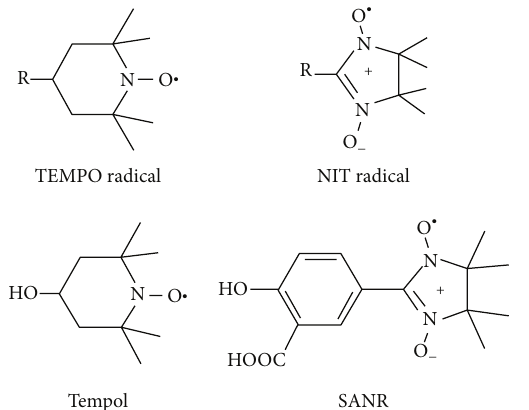
Figure 1: Structure of SANR and other nitroxide radicals. Structure of TEMPO, 𝛼 -nitronyl (NIT) group radicals, Tempol, and